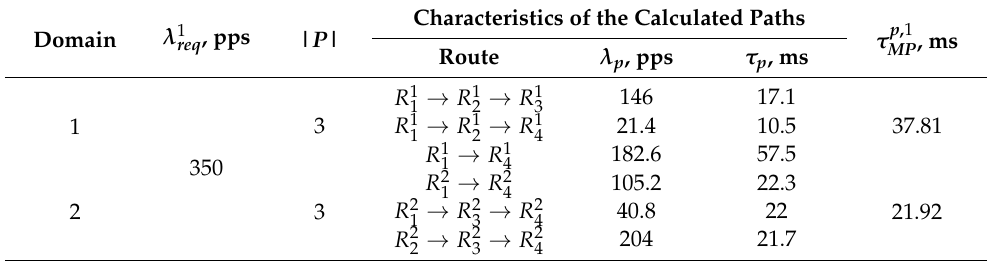
Table 5. Characteristics of the calculated routes in Figure 10.